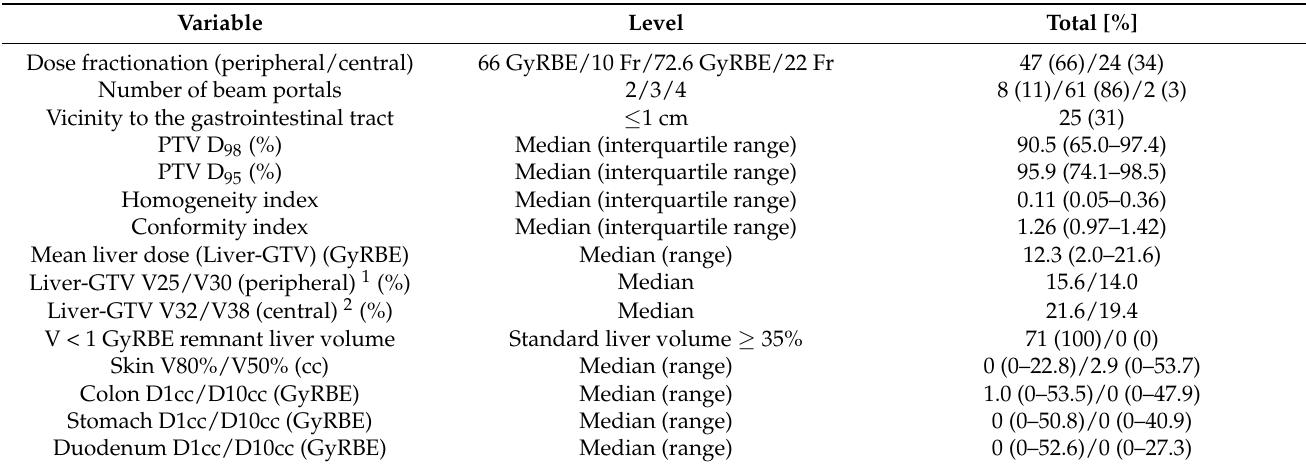
Table 2. Treatment characteristics and dose volume